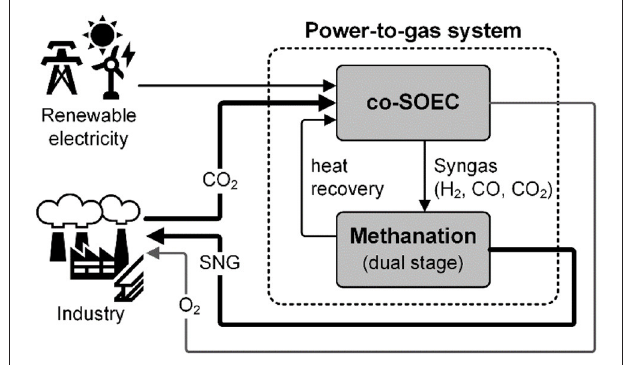
FIGURE 2 | System boundary of the power-to-gas system establishing a closed carbon cycle with the integrating industry (bold streams).